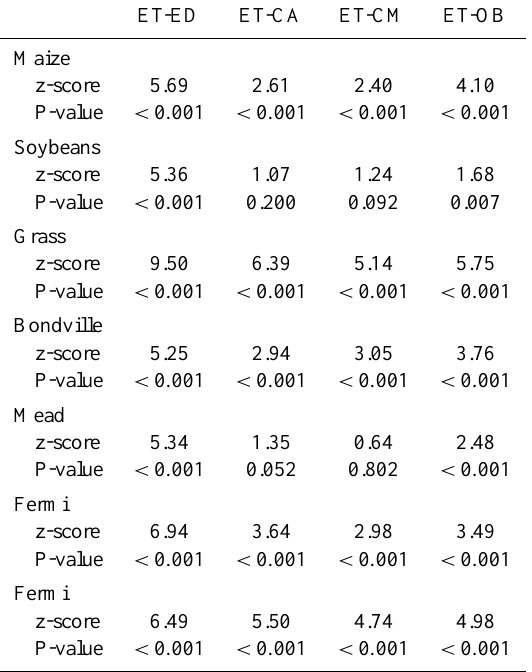
Table A2. Difference between DORs of reference evapotranspira- tion and various arrangements of VegET across crops and